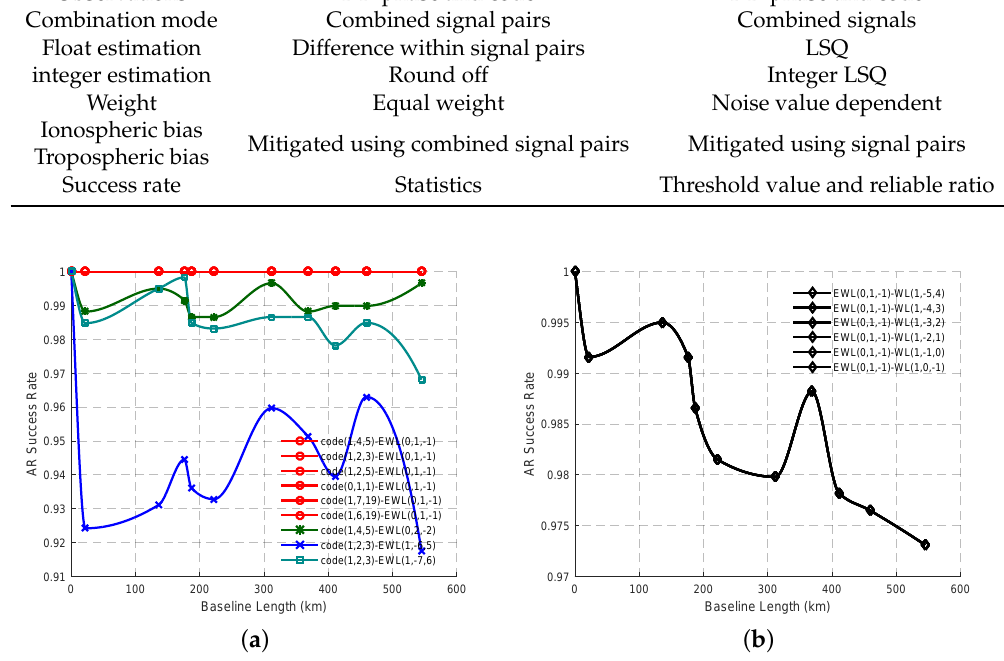
Figure 9. The variation trend of AR success rate in GF TCAR. ( a ) The signal pairs with combined code and EWL carrier phase; ( b ) The signal pairs with ambiguity corrected EWL carrier phase signal and WL carrier phase